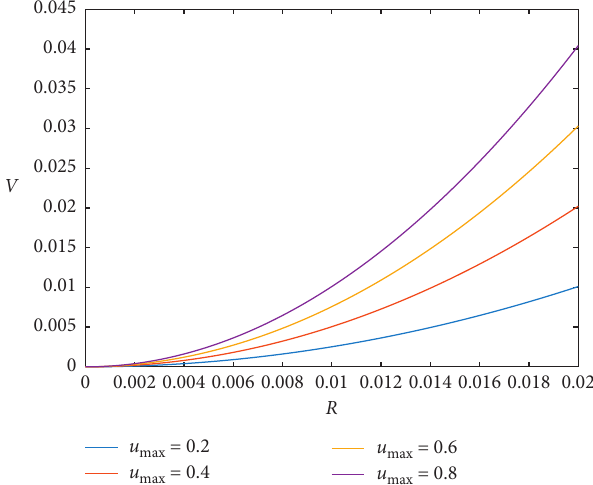
u = 0.2 max u Figure 6: Relationship between blood vessel radius and stroke volume ( α � 0 . 5 , 􏽥 c � 0 )